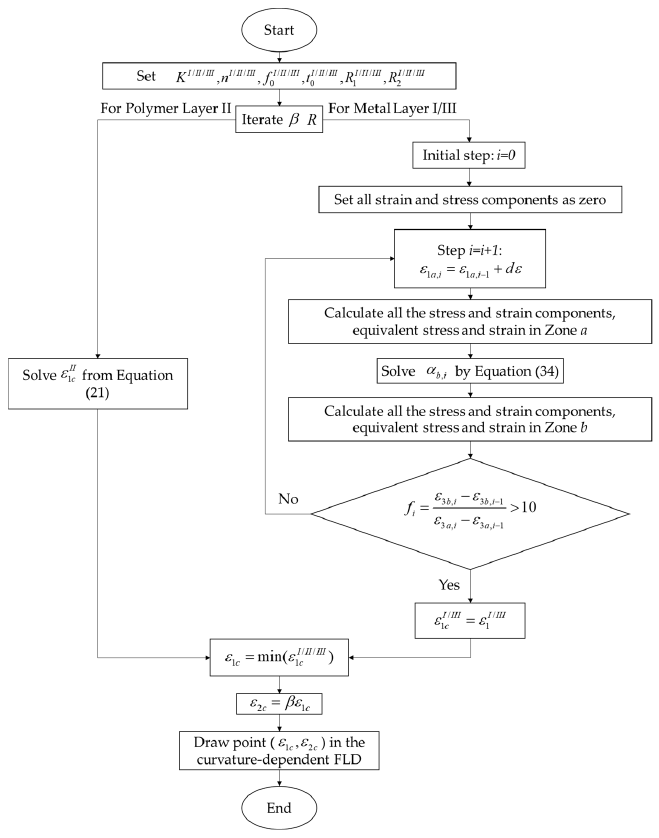
Figure 5. Flow chart of the model.